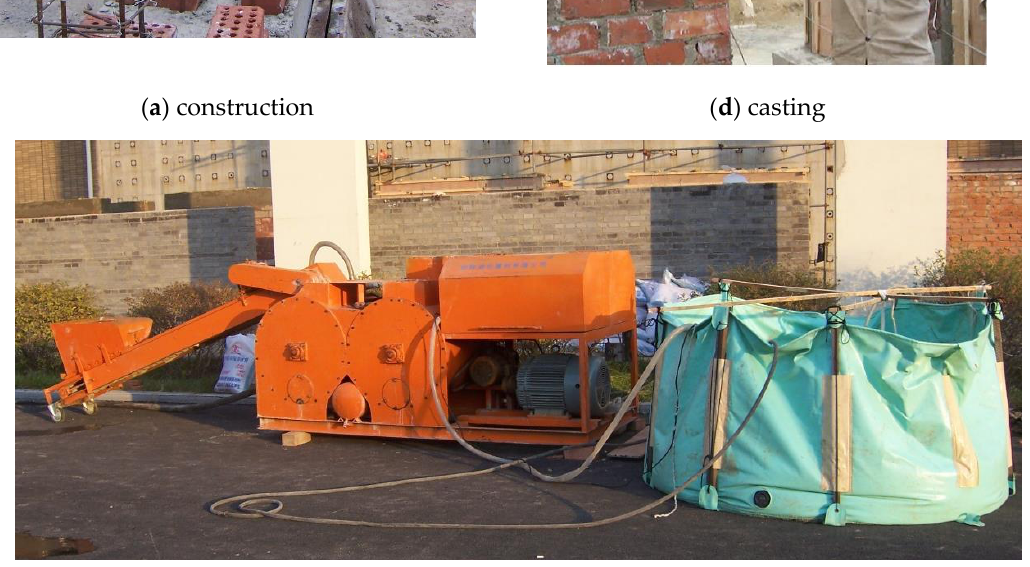
Figure 1. Illustration of masonry cavity wall construction process.